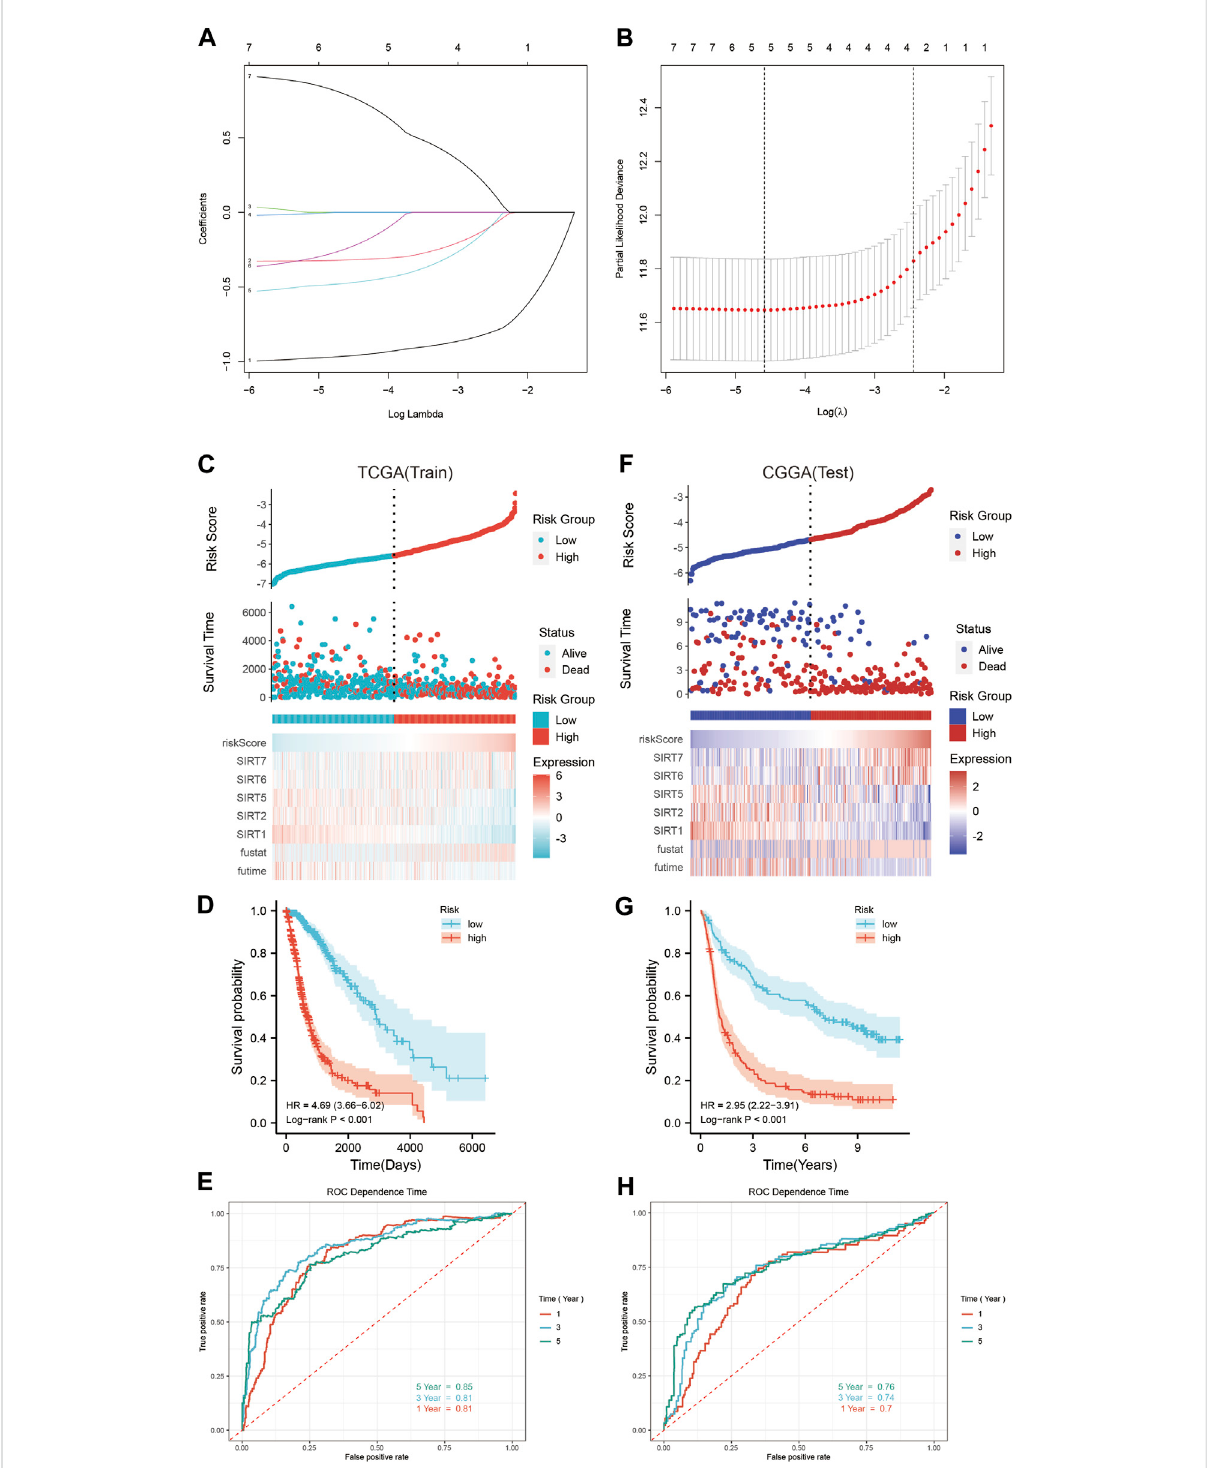
FIGURE 5 Construction and veri fi cation of SIRT-based signature. (A) Lasso coef fi cients of SIRT gene. (B) Relationship between deviance and log(lambda). (C) The distribution of risk scores, survival time and status, as well as the fi ve SIRT genes ’ expression pro fi le in glioma patients of the TCGA database. (D) Kaplan – Meier survival analysis of OS in TCGA database. (E) The SIRT-based signature predicts the time-dependent ROC curves of 1 -, 3 -, and 5- year OS in glioma patients in the TCGA database. (F) Distribution of risk scores, survival time and status, and the fi ve SIRT gene expression pro fi les in glioma patients of the CGGA database. (G) Kaplan – Meier survival analysis of OS in the CGGA database. (H) SIRT-based signature predicts thetime-dependent ROC curvesof 1 -,3 -, and 5-year OS in glioma patients in the CGGA database(* p < 0.05, ** p < 0.01, *** p < 0.001, ns: p >